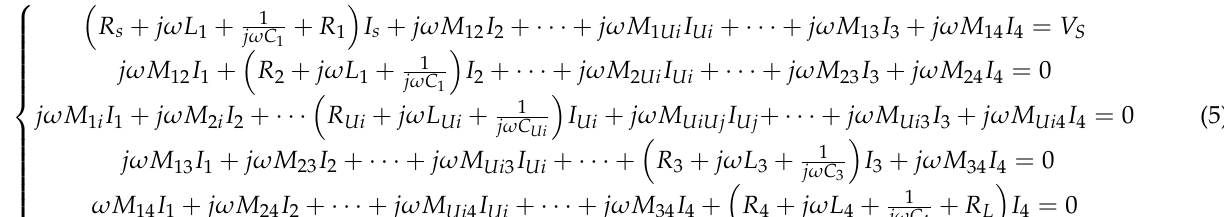
Figure 7. Equivalent circuit model of the rollable MS‑based WPT system.